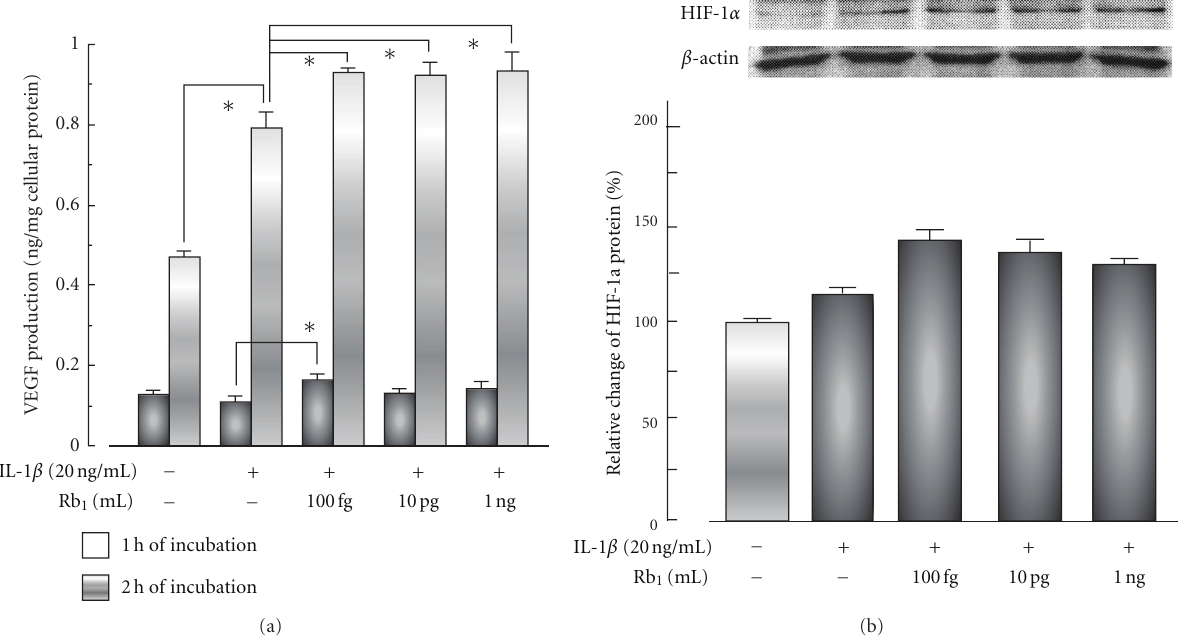
Figure 6: E ff ects of ginsenoside Rb 1 on VEGF production (a) and HIF-1 α expression (b) with or without IL-1 β in HaCaT cells [26]. The human keratinocyte cell line HaCaT was treated with the indicated amounts of ginsenoside Rb 1 in the presence or absence of IL-1 β (20ng/mL) for 1 or 2 h. VEGF levels in the medium were measured using a human VEGF kit. The expression of hypoxia-inducible factor (HIF-) 1 α in the nuclear fraction of HaCaT cells was measured by western blot analysis with mouse anti-HIF-1 α and anti- β -actin antibodies. Values are the mean ± SE for six experiments. ∗ Significantly di ff erent from control, P < 0 . 05.